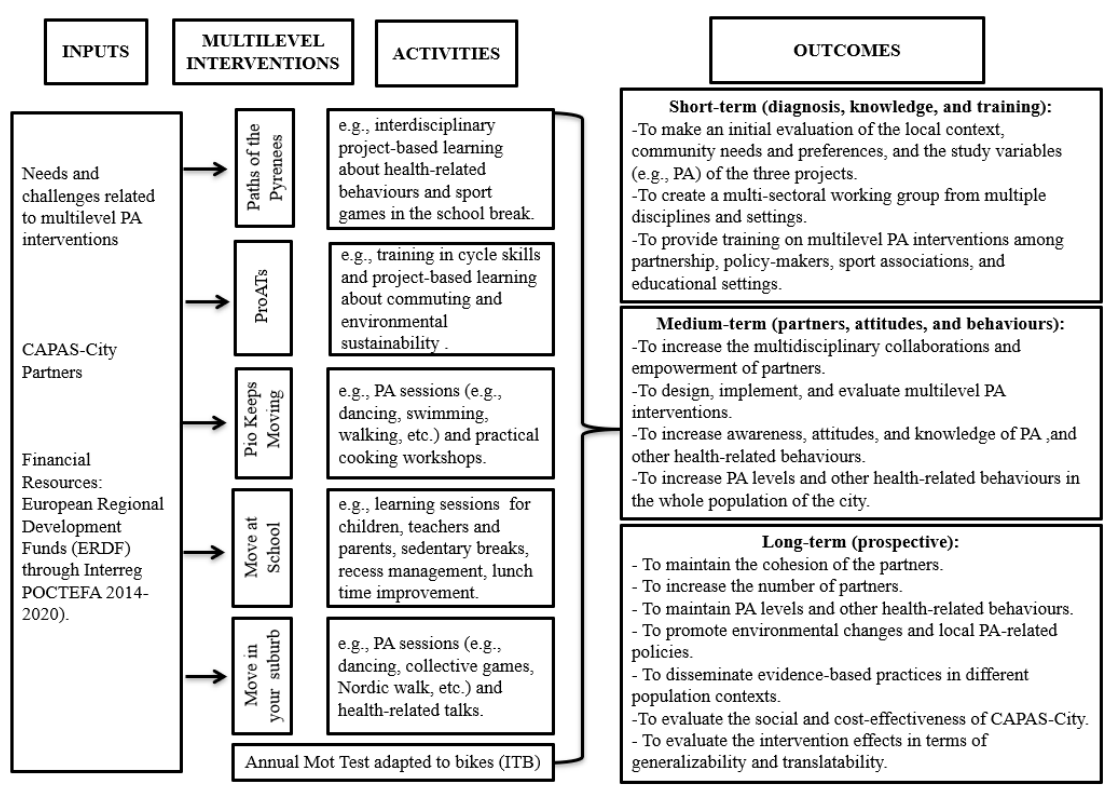
Figure 2. Summary of the organizational model used by CAPAS-City: Inputs, multilevel interventions, activities, and outcomes.